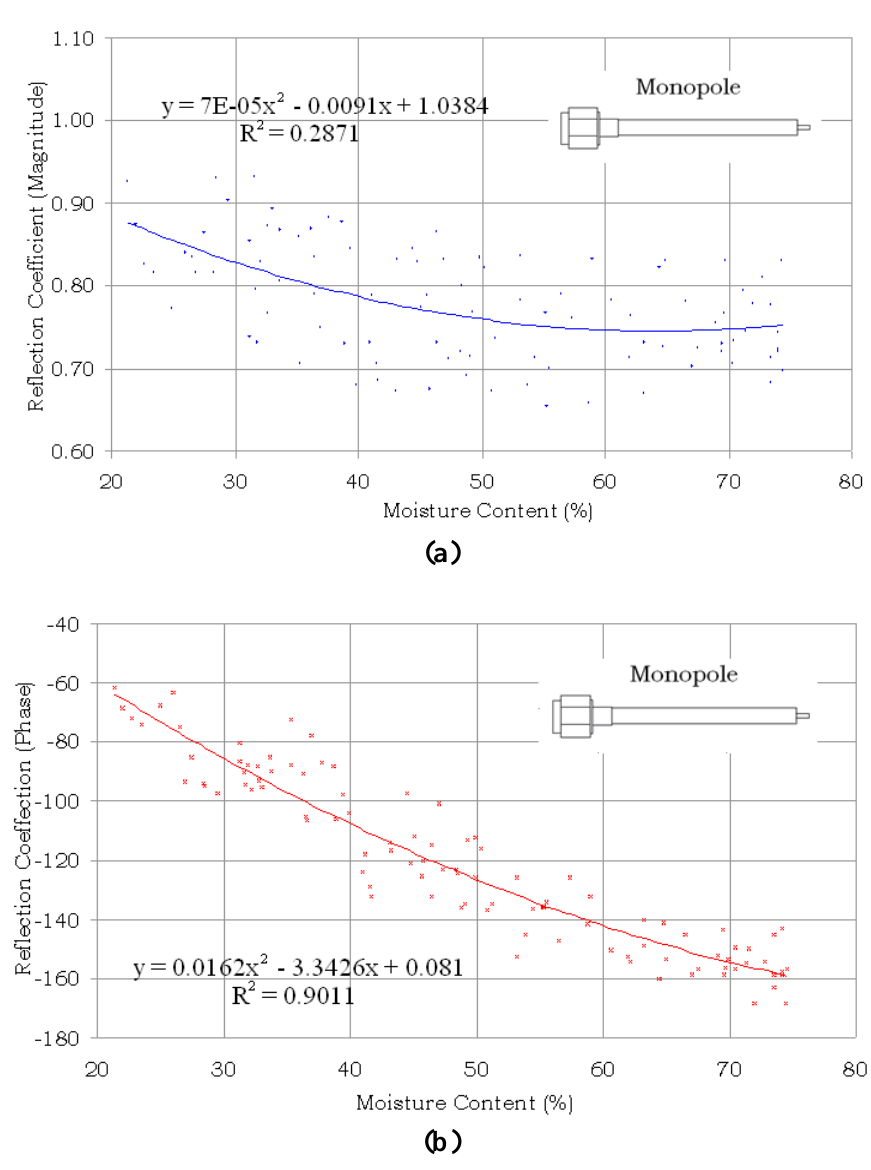
Figure 5. Variation in magnitude and phase of S sensor. (a) Magnitude; (b)